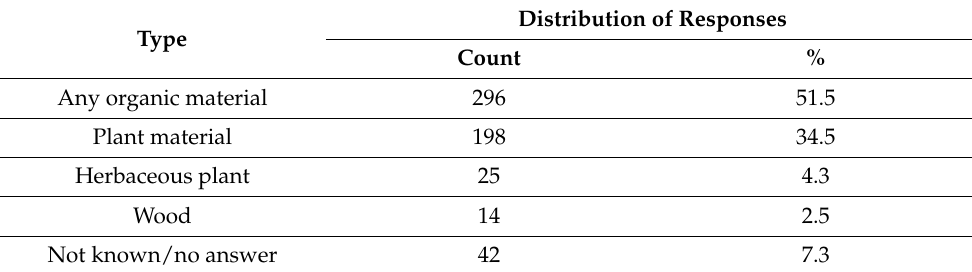
Table 4. Detailed knowledge of the term “biomass” ( N = 575).